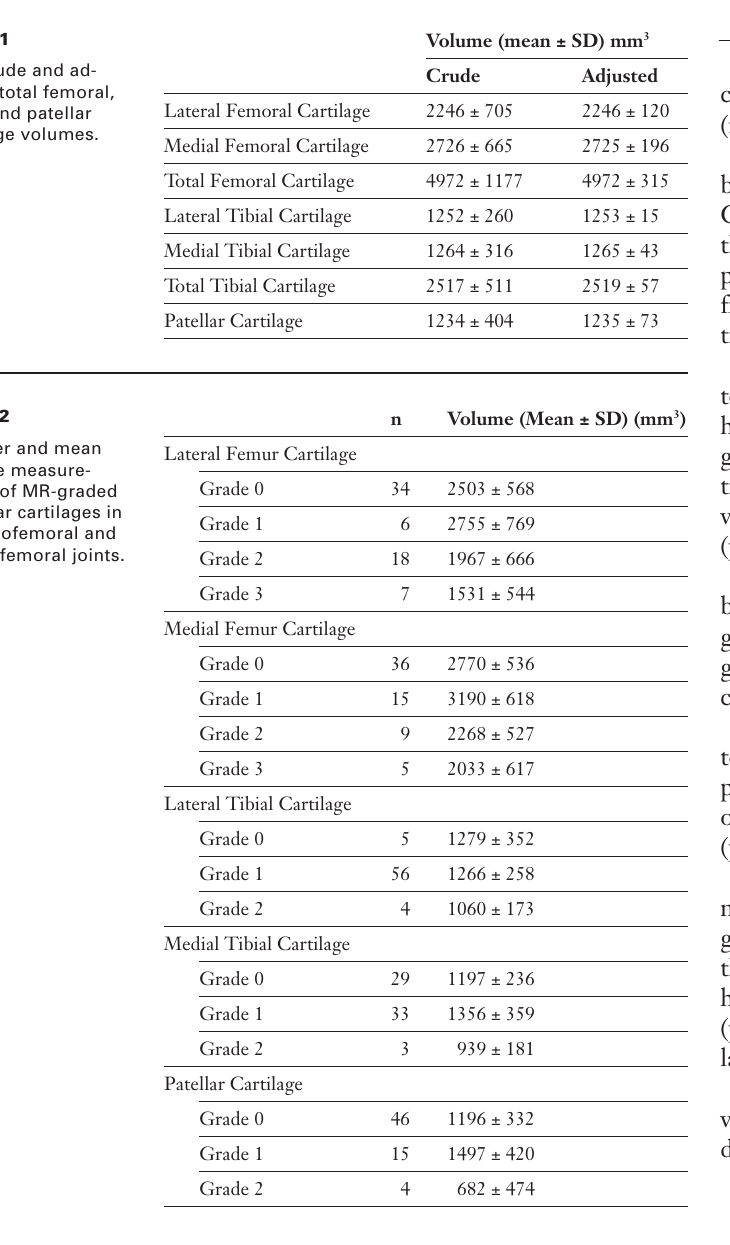
The distribution of MR grades in lateral femoral, medial femoral, lateral tibial, medial tibial and patellar cartilage and their relationship with volume measurement. LFC: lateral femoral cartilage; MFC: medial femoral cartilage; LTC: lateral tibial cartilage; MTC: medial tibial cartilage; PC: patellar